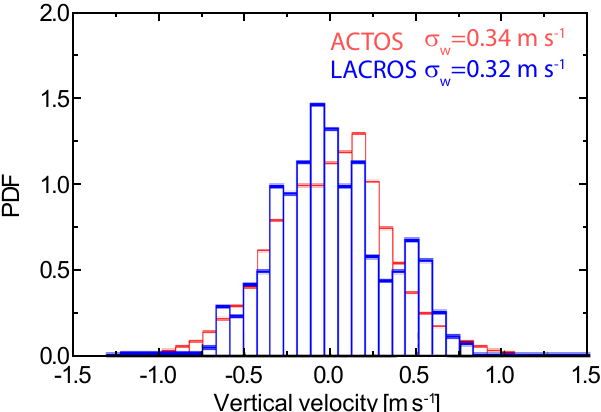
Figure 7. Simultaneous observation of the vertical-velocity vari- ations in a stratocumulus layer performed in-cloud with ACTOS (red) and at cloud base with Doppler wind lidar WiLi of LACROS (blue) on 22 September 2013 during HOPE-Melpitz. The mean ver- tical velocity of both observations was set to zero to correct for large-scale vertical motions. Adapted from Seifert et al.